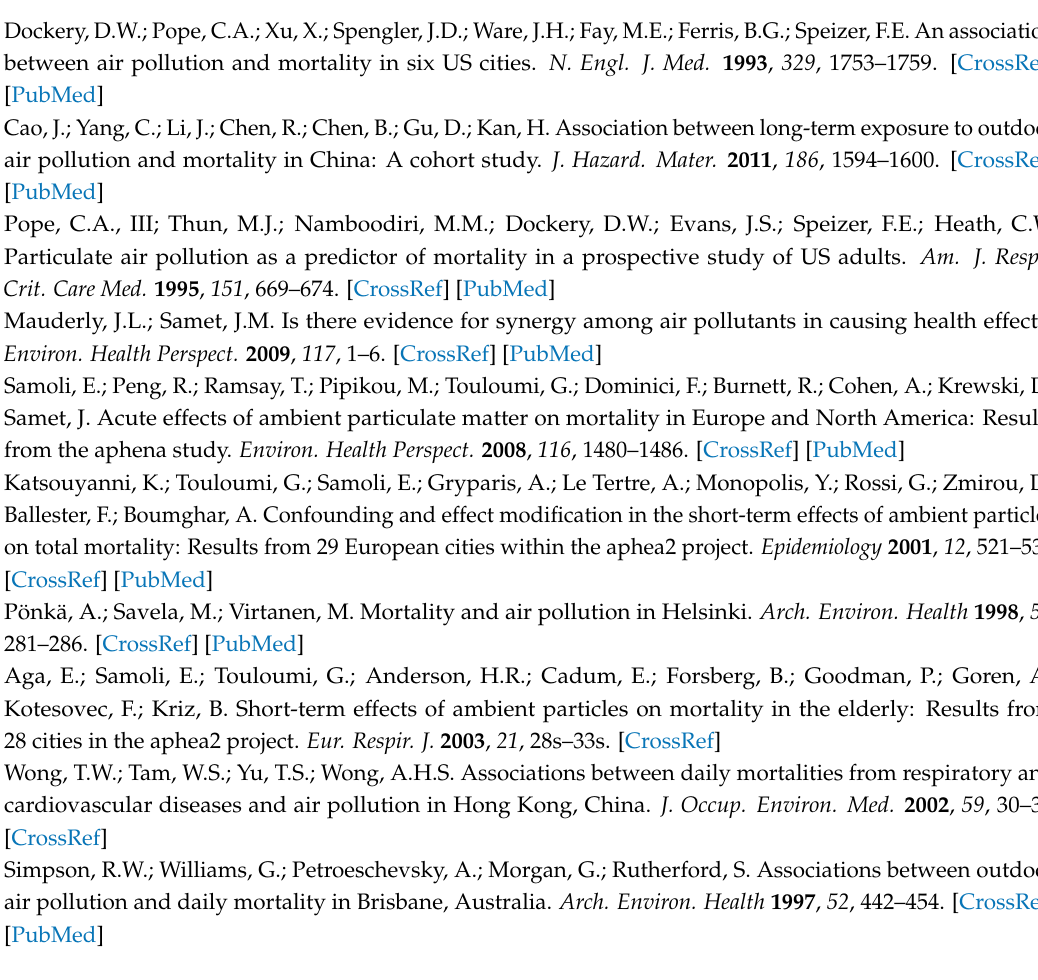
Figure S1: Joint effect graphs of lag 0–2 days PM 10 and NO 2 on mortality with different df of long-term trend, Table S1: ERRs (%) with 95% confidence intervals for mortality for each 10 µ g/m 3 increment of lag 0–2 days PM 10 across NO 2 levels with different dfs of long-term trend, Table S2: ERRs (%) with 95% confidence intervals for mortality for each 10 µ g/m 3 increment of lag 0–2 days NO 2 across PM 10 levels with different dfs of long-term